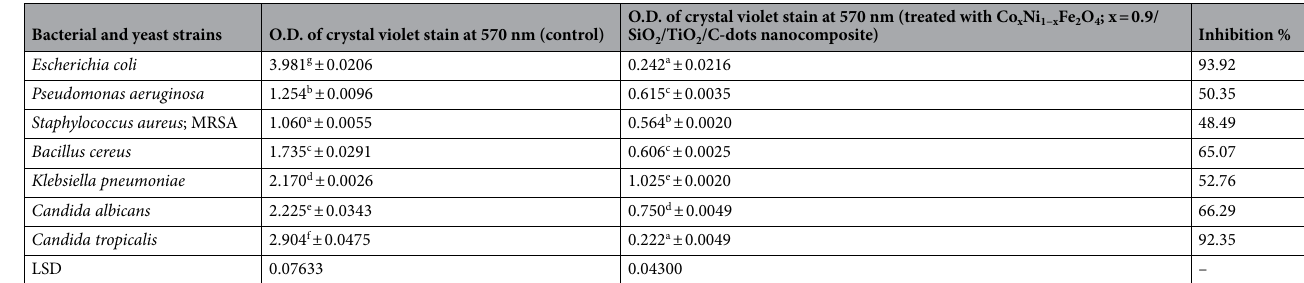
Table 2. Semi-quantitative inhibition of the biofilm formation by non-treated and nanocomposite-treated bacterial and yeast pathogens. Values are presented as means ± SD (n = 3). Data within the groups were analyzed using one-way analysis of variance (ANOVA) followed by superscript letters (a–g) Duncan’s multiple range test (DMRT), LSD least significant